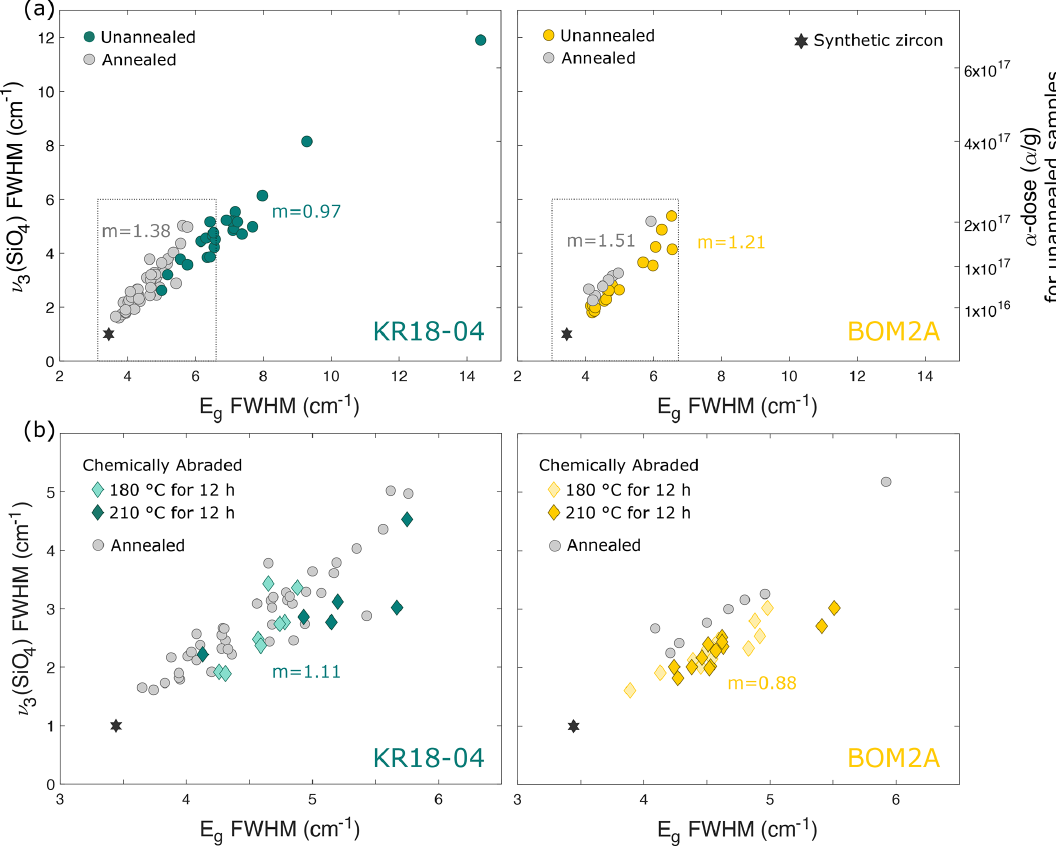
Figure 6. Raman v 3 (SiO 4 ) and E g peak width data for lower-damage samples KR18-04 and BOM2A. (a) Results for unannealed and annealed (900 ◦ C for 48h) zircon samples. Alpha dose estimates for unannealed zircon samples derived from v 3 (SiO 4 ) peak width measure- ments are shown on the right y axis (Váczi and Nasdala, 2017). Slopes ( m ) for unannealed and annealed samples were calculated assuming a simple linear regression. Gray boxes mark the plot area presented in (b) . (b) Results for chemically abraded residues compared to annealed samples. Reported slopes are inclusive of all leaching